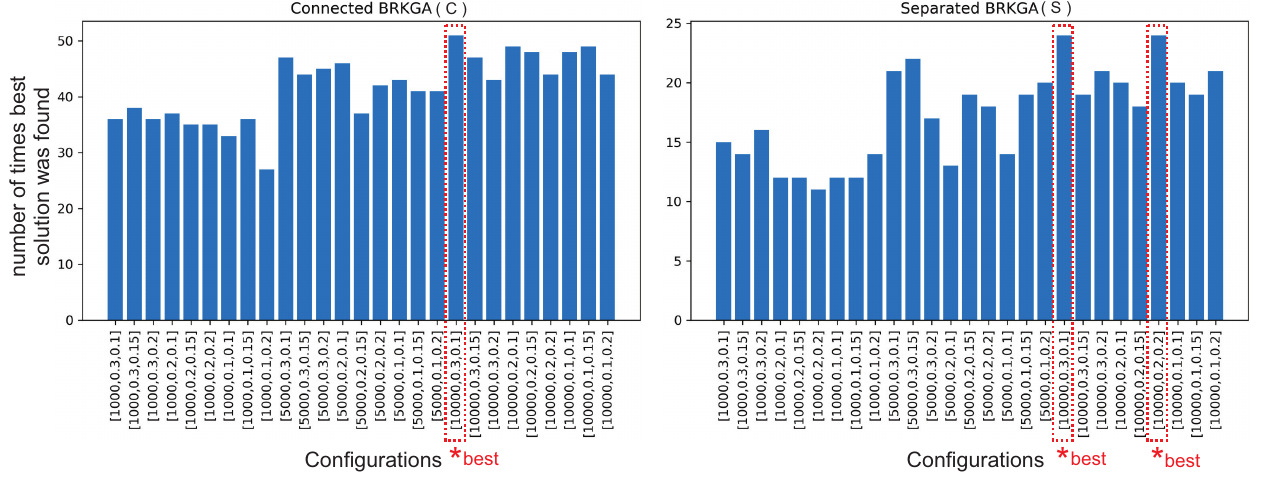
Figure 11. Analysis of the proposed configurations for BRKGA ( relation-1